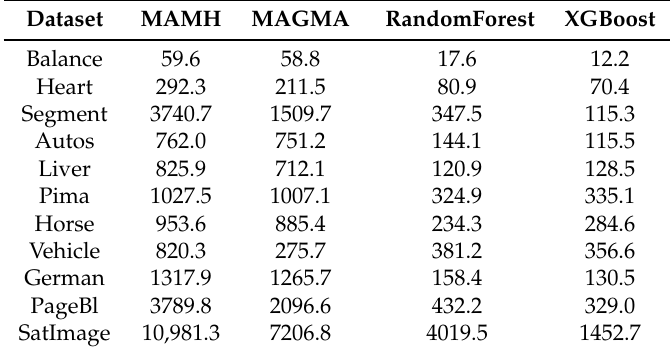
Table 10. The processing time (s) of the hybrid architectures and two ensemble